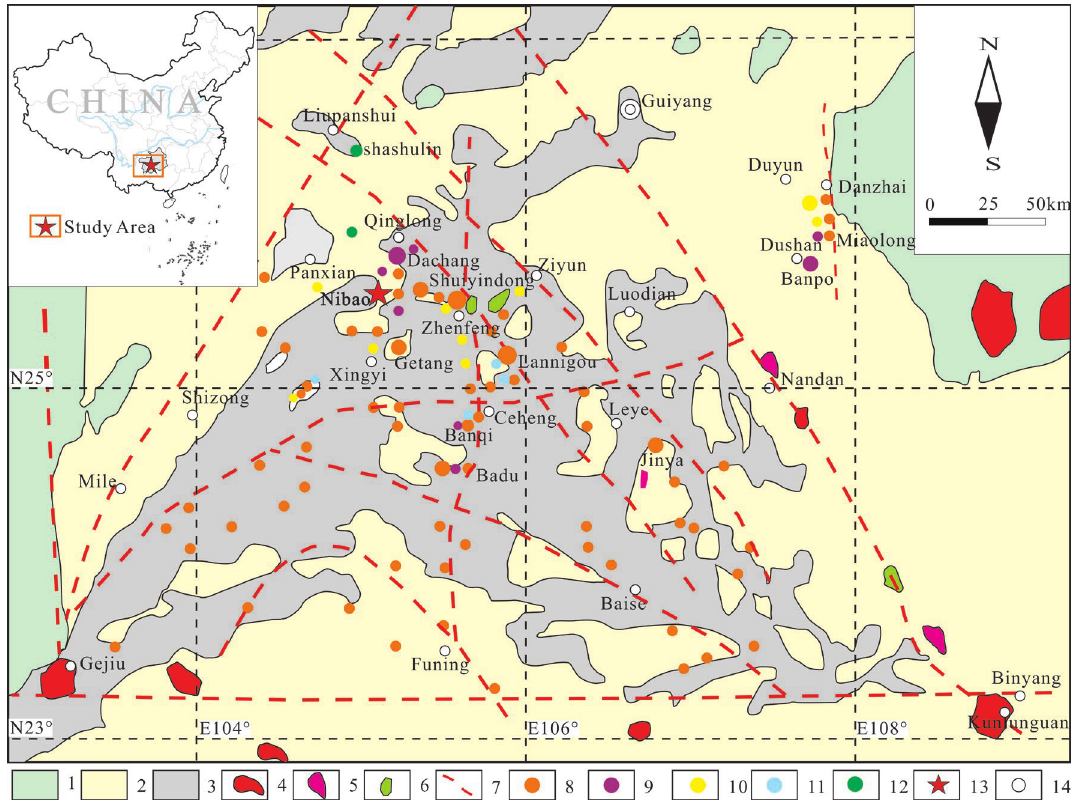
Figure 1. Geological map of low-temperature hydrothermal deposits distributed in the Yunnan–Guizhou–Guangxi “Golden Triangle” region: 1. Proterozoic; 2. Paleozoic; 3. Triassic; 4. Granite; 5. Quartz porphyry; 6. Alkaline mafic–ultramafic rock; 7. Fault; 8. Gold deposit; 9. Antimony deposit; 10. Mercury deposit; 11. Arsenic deposit; 12. Lead–zinc deposit; 13. Nibao gold deposit; 14. County town.